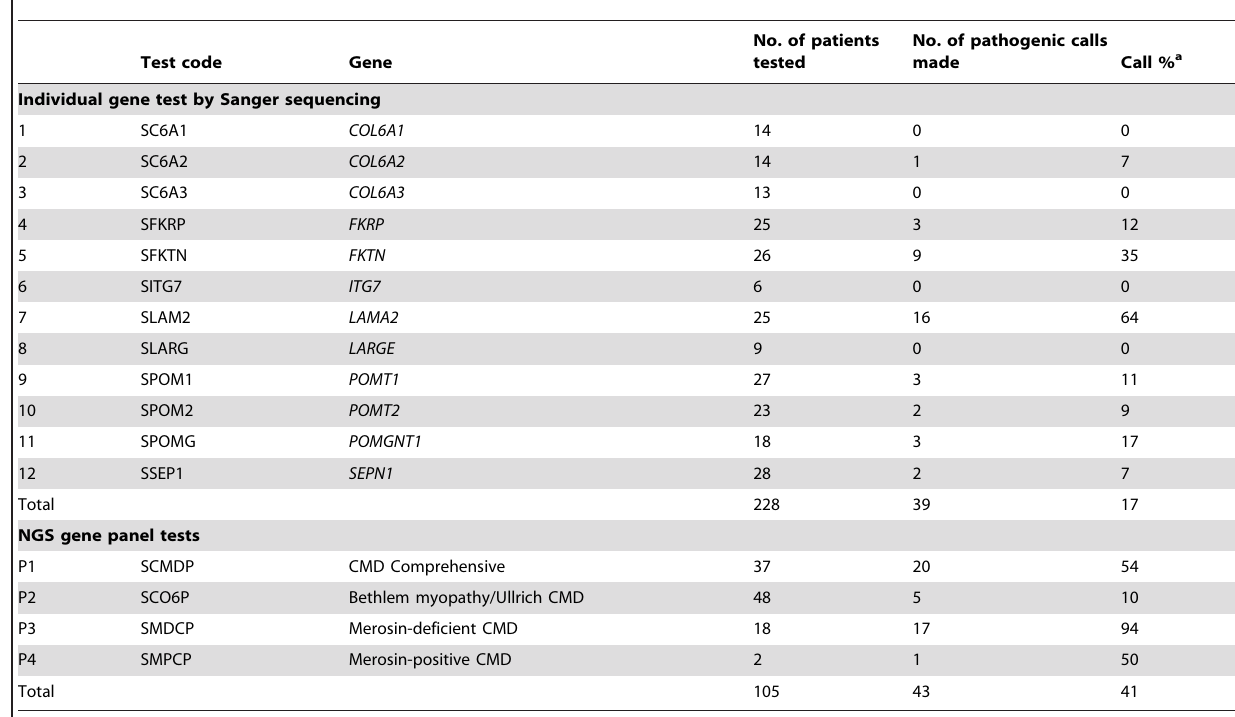
Table 8. Comparison of clinical yields of single-gene versus NGS panel tests.